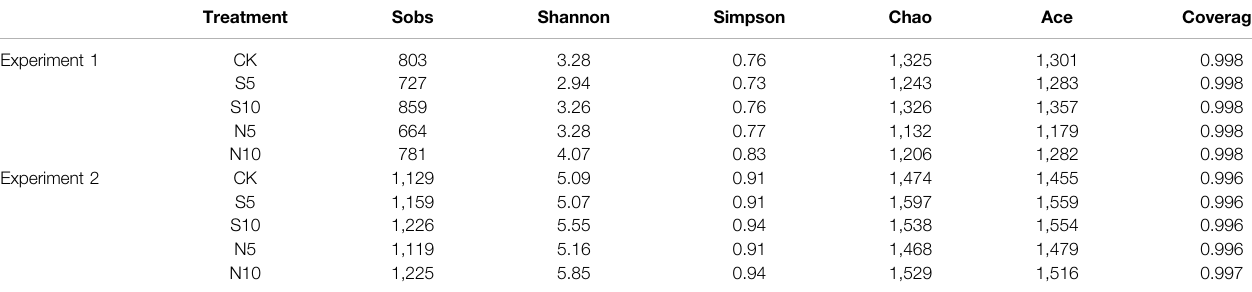
TABLE 5 | Alpha diversity of the bacterial community of stylo silage mixed with stylo meal and N. cadamba leaf meal ( n = 3). Treatment Sobs Shannon Simpson Chao Ace Coverage Experiment 1 CK